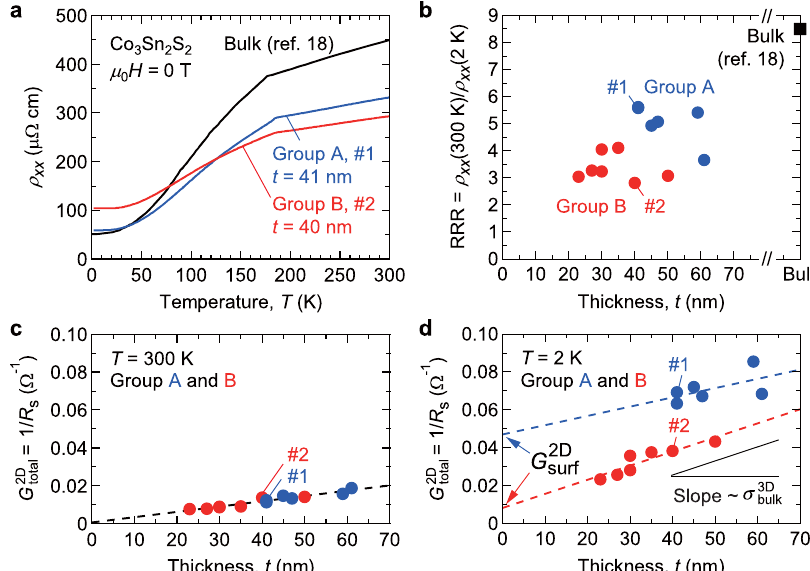
Fig. 2 Temperature T and thickness t dependence of electrical conduction in Co 3 Sn 2 S 2 thin fi lms. a T dependence of resistivity ρ xx for a reference of bulk (black curve from Liu et al. 18 ), fi lm #1 (blue curve; t = 41 nm) from Group A, and fi lm #2 (red curve; t = 40 nm) from Group B. b Residual resistivity ratio RRR for the fi lms as a function of thickness, which guided to categorize the fi lms to Group A and B by the criteria at roughly RRR = 4. The bulk value of RRR = 8.5 (Liu et al. 18 ) is included for comparison. c , d To detect the t -independent conductance, sheet conductance G 2D for various thickness fi lms at total T = 300 K and 2 K are plotted, respectively. The slope corresponds to three-dimensional conductivity σ 3D . The detection of intercept in d indicates the bulk emergence of t -independent two-dimensional surface conductance G 2D . The experimental data in a and d are replotted from Ikeda et al. 25 surf